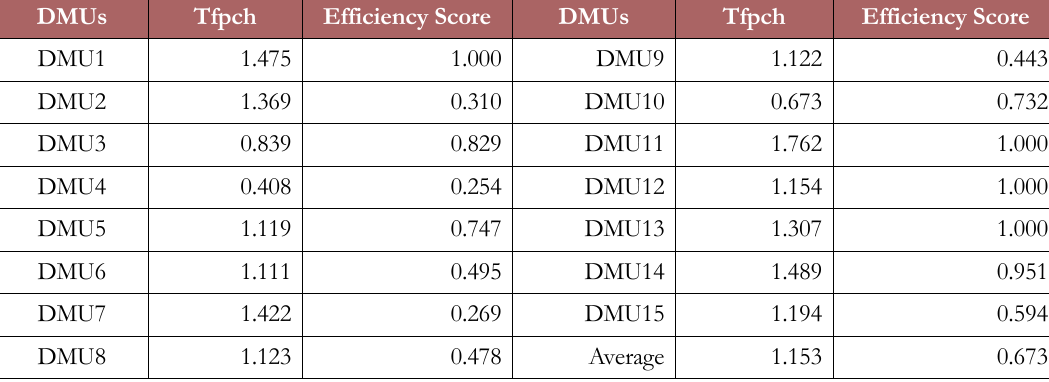
Table 7. Total Factor productivity index and efficiency score for 15 DMUs in